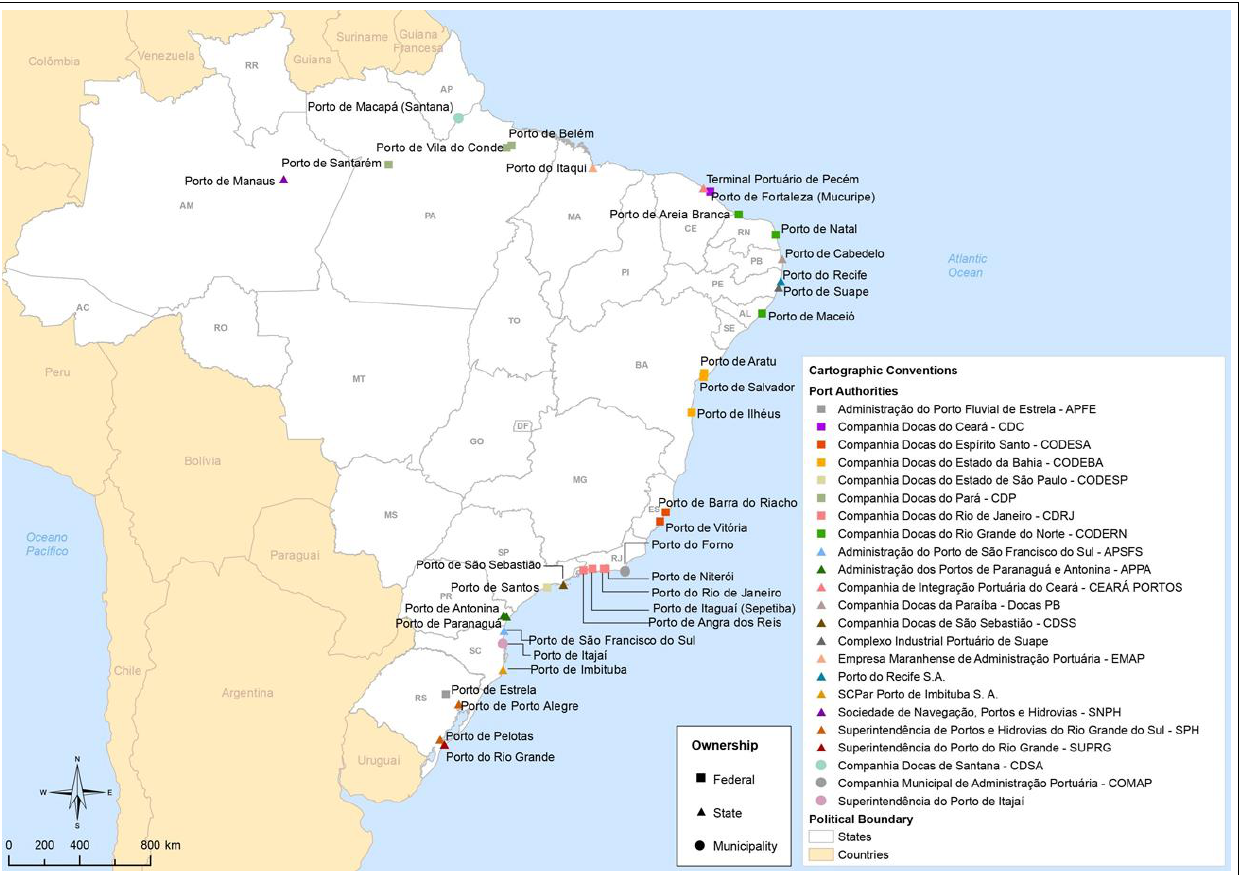
Figure 4. Map of Brazilian ports. Source: